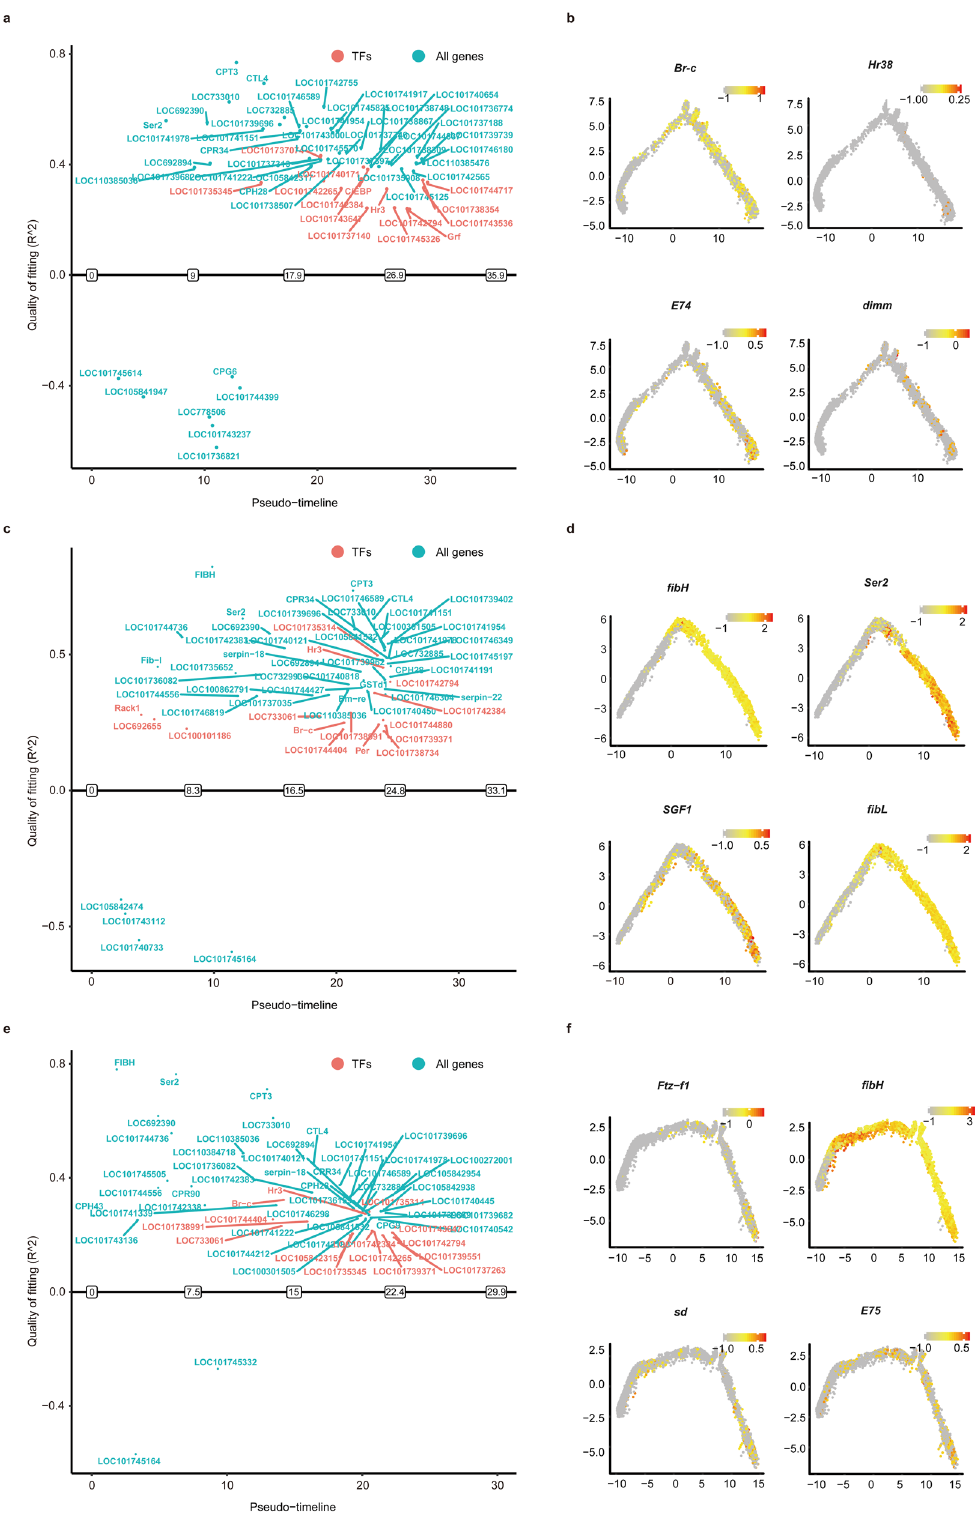
Fig. 5 Schematic diagram of priority activated and inactivated genes in cell types of the silk gland. a , c , e Representative activated (top panel) and inactivated (bottom panel) genes in anterior silk gland ( a ), middle silk gland ( c ), and posterior silk gland ( e ) cells. The X-axis shows the predicted open (upper panel) and closed (lower panel) times. The Y-axis represents the goodness of fi t. Early genes, switch-at-time < 9.0 ( a )/8.3 ( c )/7.5 ( e ); late genes, switch-at-time > 26.9 ( a )/24.8 ( c )/22.4 ( e ). TFs, transcription factors. b , d , f Trajectory along the pseudotime progression of representative genes that were activated and inactivated in anterior silk gland ( b ), middle silk gland ( d ), and posterior silk gland ( f ) cells. The X-axis represents Component 1, the Y-axis represents Component 2. The formula of this trajectory plot is log 10 (value +